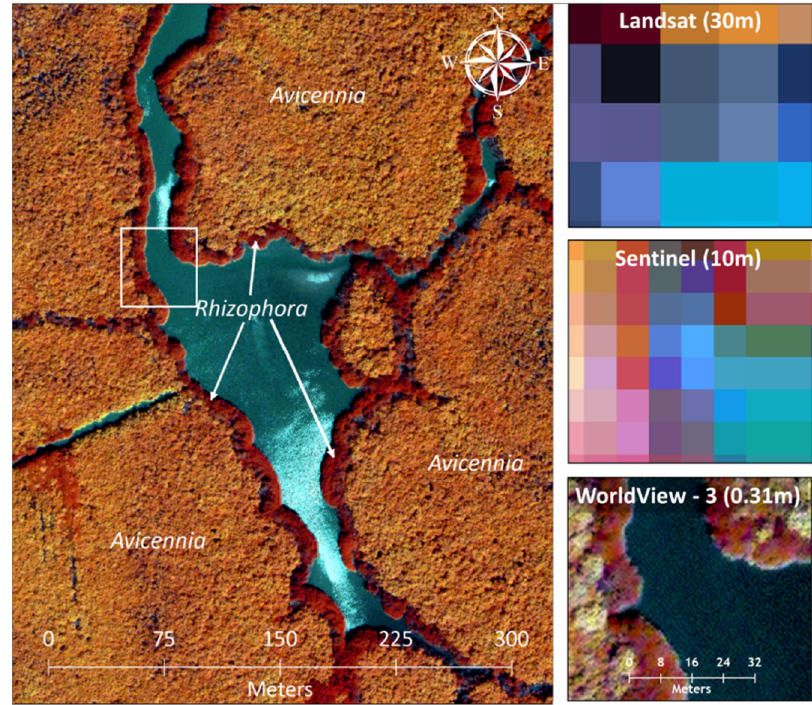
Figure 1. Importance of spatial resolution for mapping changes in mangrove cover. Mangrove subsets from MSR images from Landsat-8 (15 March 2019) and Sentinel-2 (31 May 2019), along with very high spatial resolution image Worldview-3 (28 January 2019).